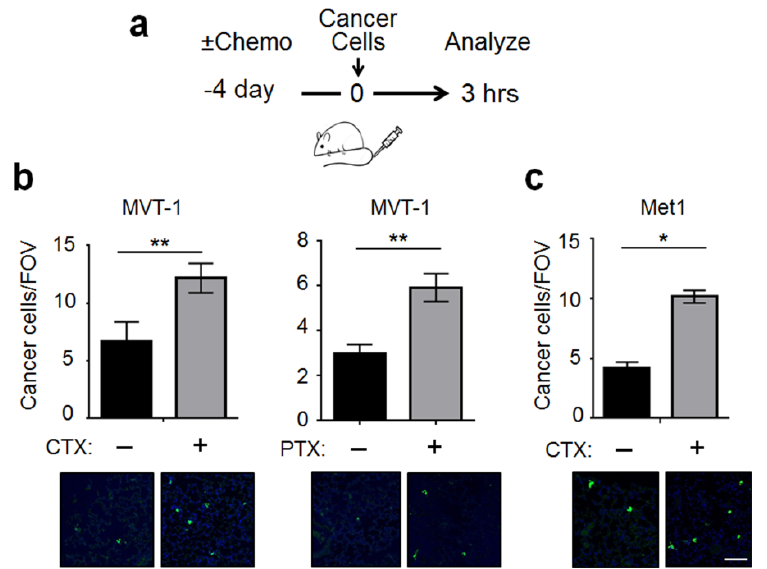
Figure 1. Chemotherapy pre-treatment modified the lung microenvironment to increase its adhesiveness to cancer cells. ( a ) A schematic of the lung colonization model with chemotherapeutic agent (+) or vehicle (−) treatment on day 4 before tail vein injection of the indicated breast cancer cells. ( b ) Left : Quantification of lung cancer cells per field of view (FOV) in mice pre-treated with CTX or vehicle. Right : Same as the left panel except PTX and its vehicle were used. Bottom: Representative images (showing a portion of the FOV). ( c ) Same as the left panel in ( b ) except the tGFP-Met1 breast cancer cells were used ( n = 6–9 from 2–3 independent experiments). Scale bar: 50 μm. Bars indicate mean ± SEM; Student’s t test; * p < 0.05; ** p < 0.01.